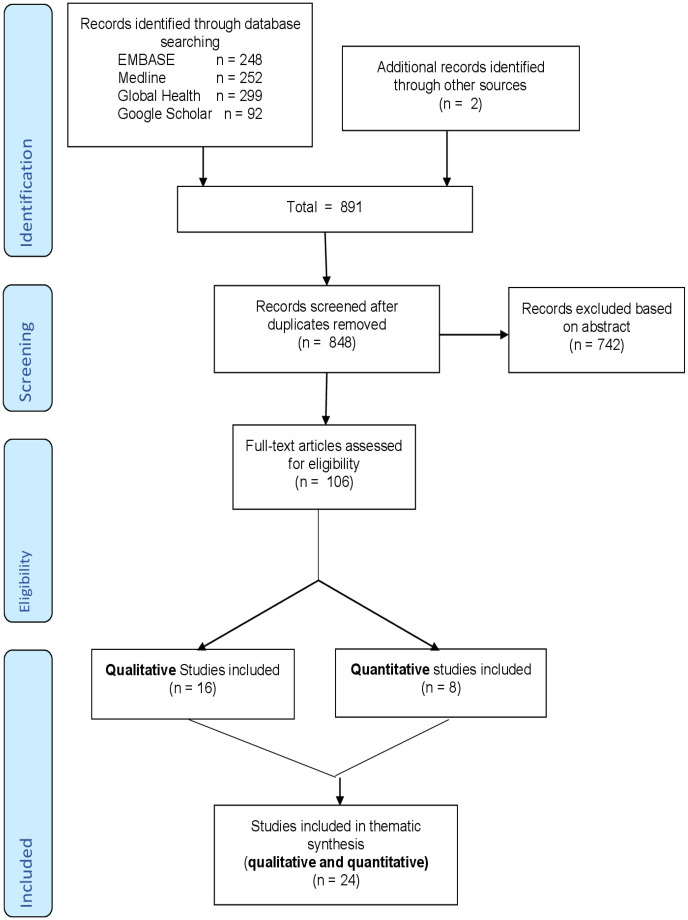
PRISMA flow diagram.